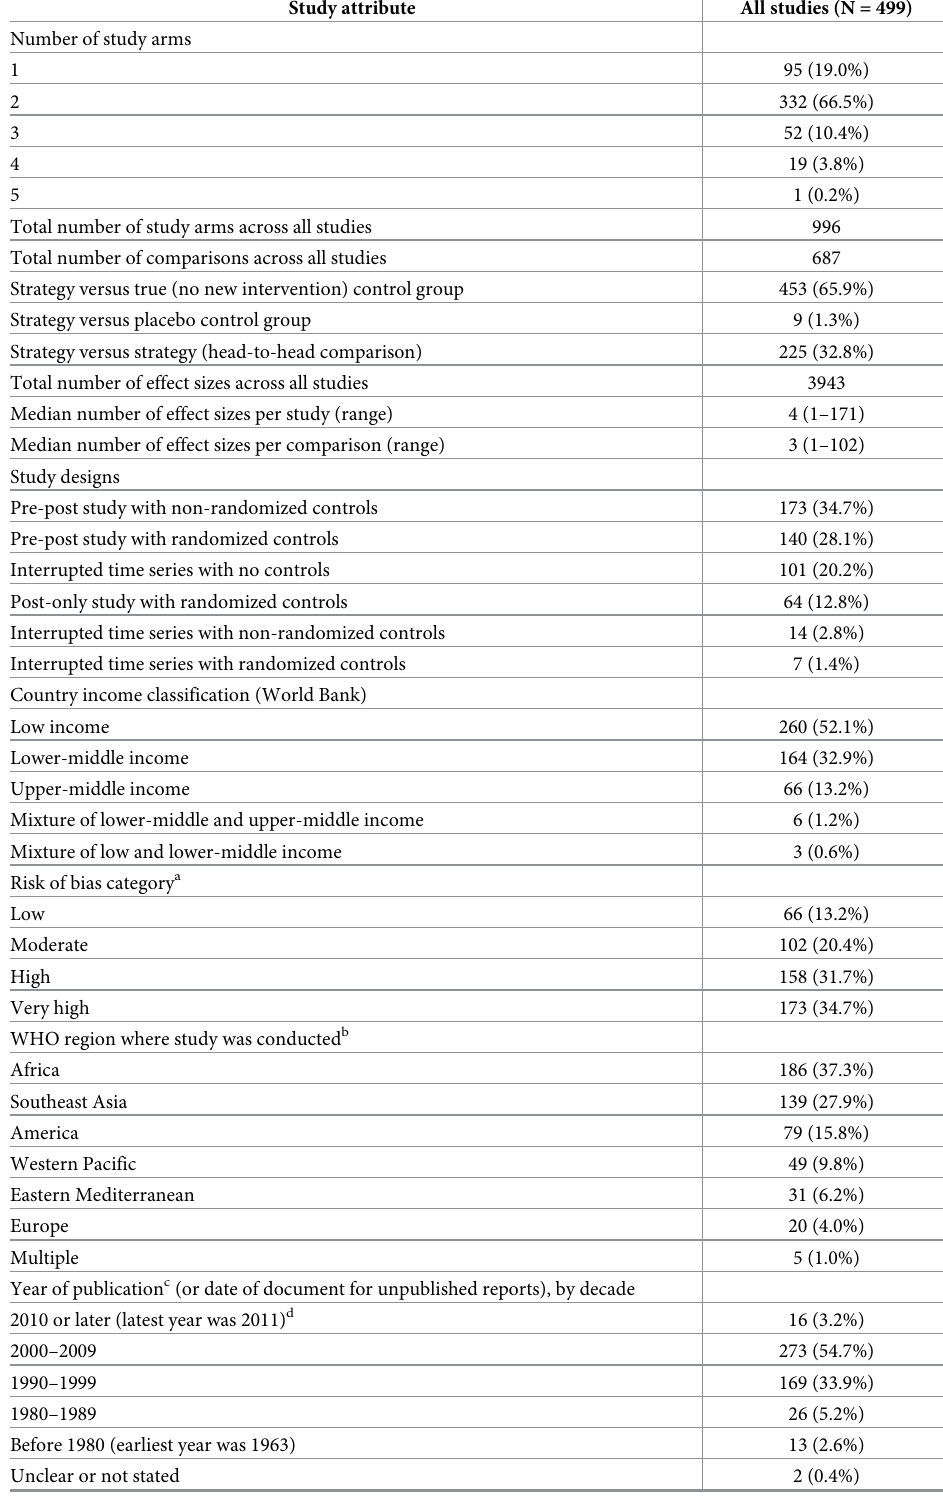
Table 2. General study